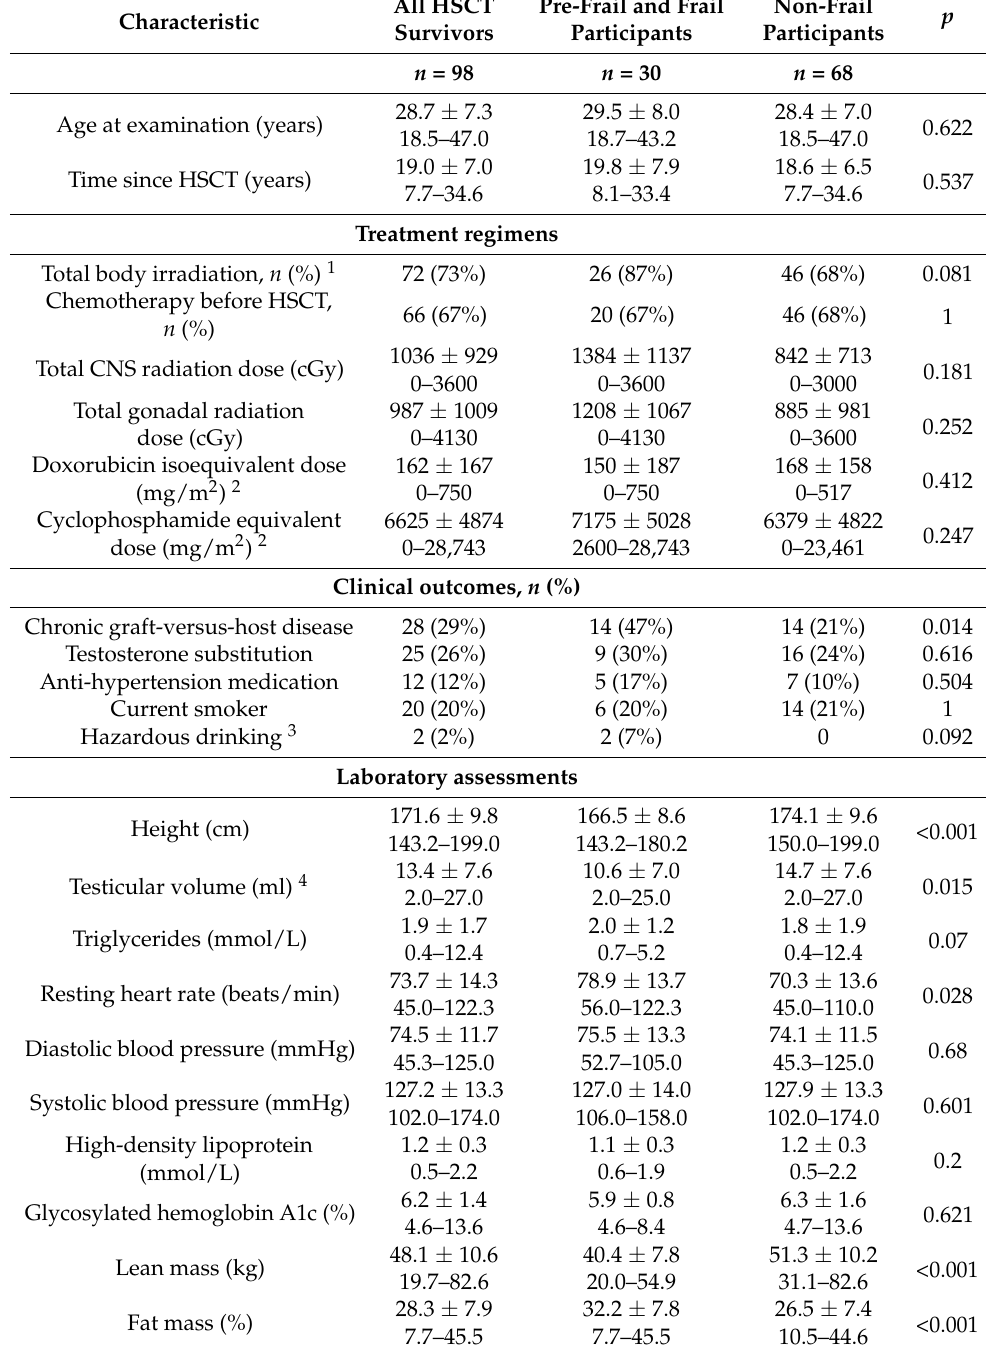
Table 1. Background characteristics of all study participants as well as the pre-frail and frail subgroup compared to non-pre-frail and non-frail